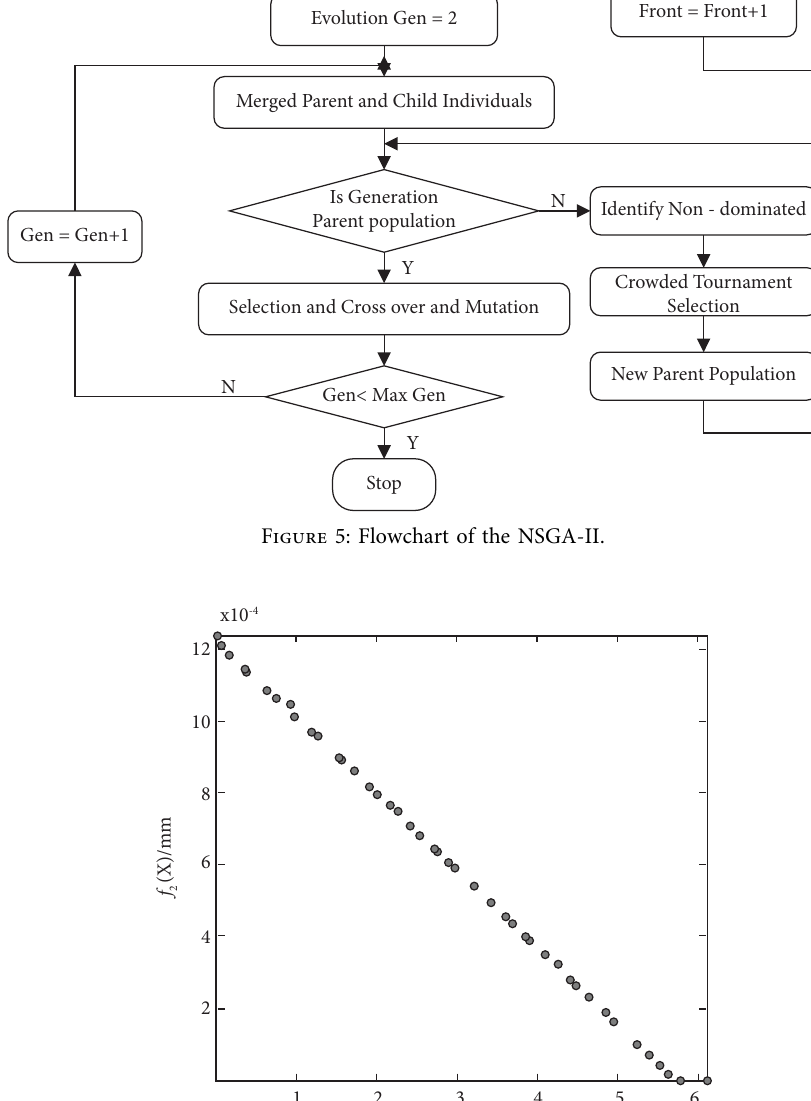
1 and wall thickness f 2 .